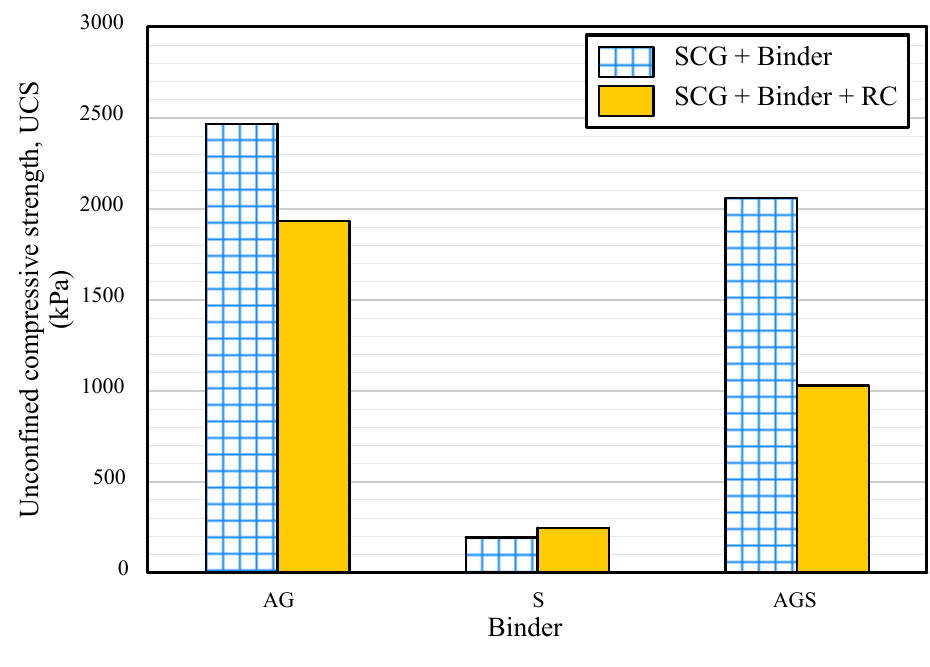
Figure 6. Unconfined strength of the samples.